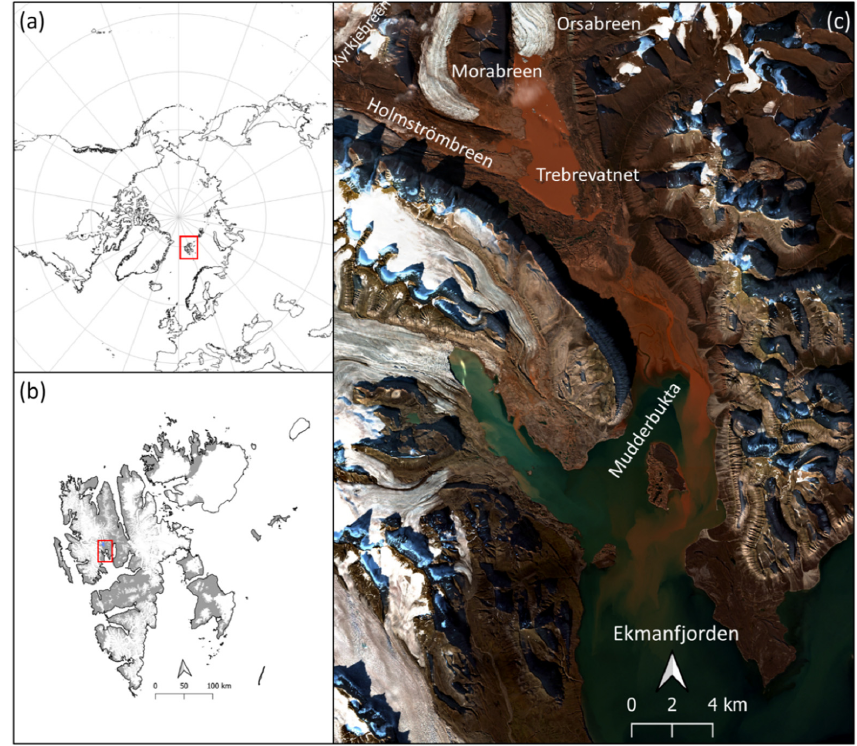
Figure 1. ( a ) Study site location; Svalbard within the Arctic region; ( b ) Central Svalbard with location of Ekmanfjorden; ( c ) Sentinel-2 image (2 September 2021) of the study area with the Trebrevatnet lake filled with suspended sediments on top of the image together with the sediment plume visible on the outlet to the Ekmanfjorden.